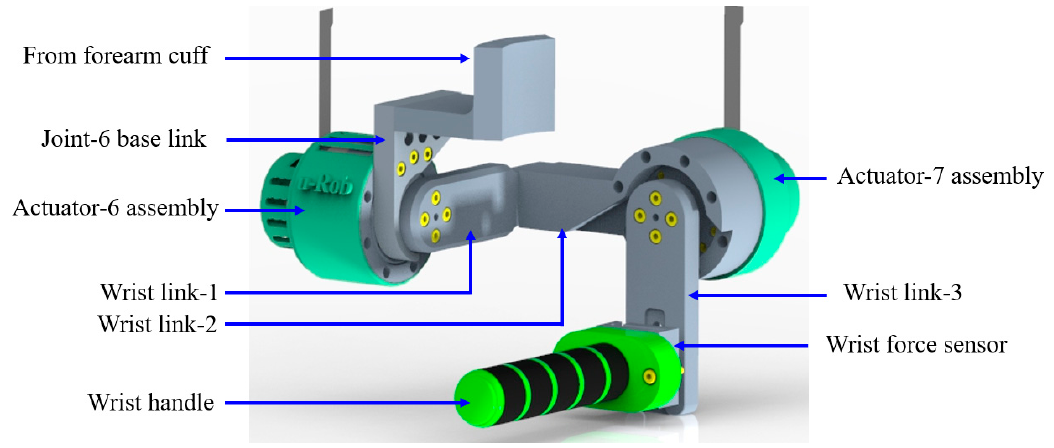
Figure 11. Wrist motion support part of the proposed exoskeleton robot.